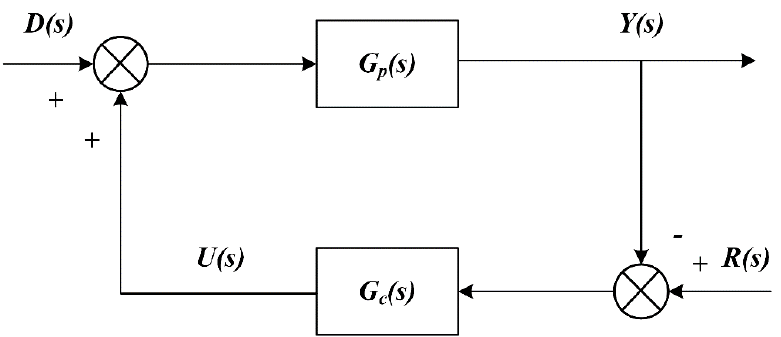
Figure 2. Block diagram of PLL ‐ based nuclear spin control loop . D(s) is the external disturbance, Y(s) is the observed detuning phase, R(s) is the reference phase, and U(s) is the output of the controller. G p (s) and G c (s) is the transfer function of the plant and the controller, respectively.